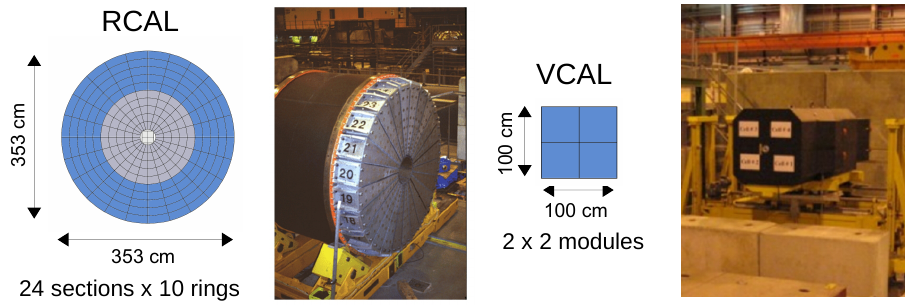
Figure 1. Schematic view and images of ring calorimeter (RCAL - left) and veto calorimeter (VCAL - right)